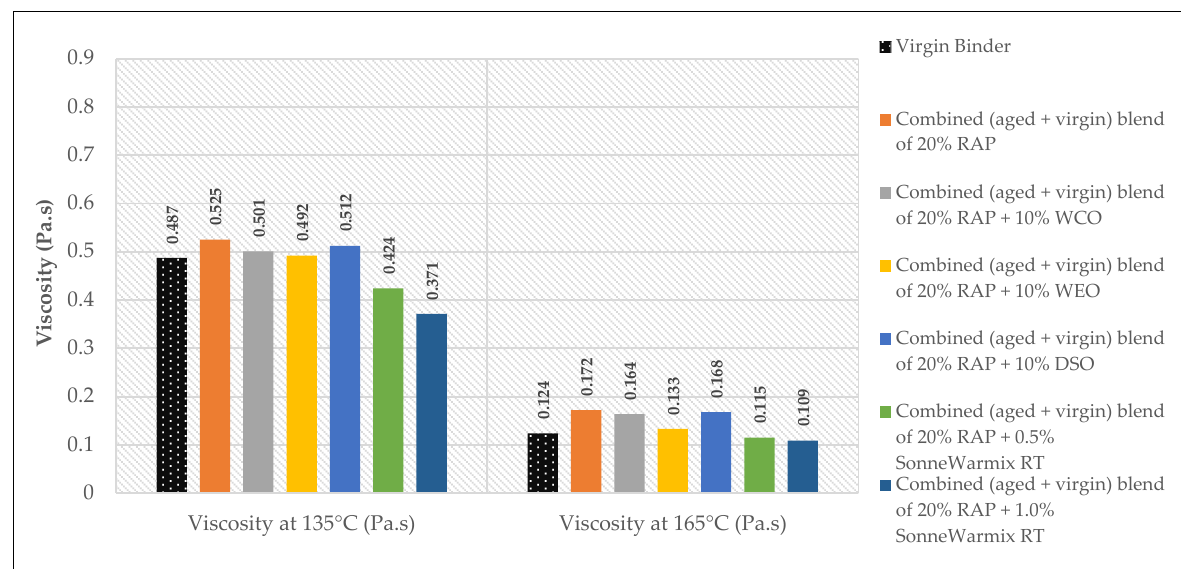
Figure 13. Blending process.